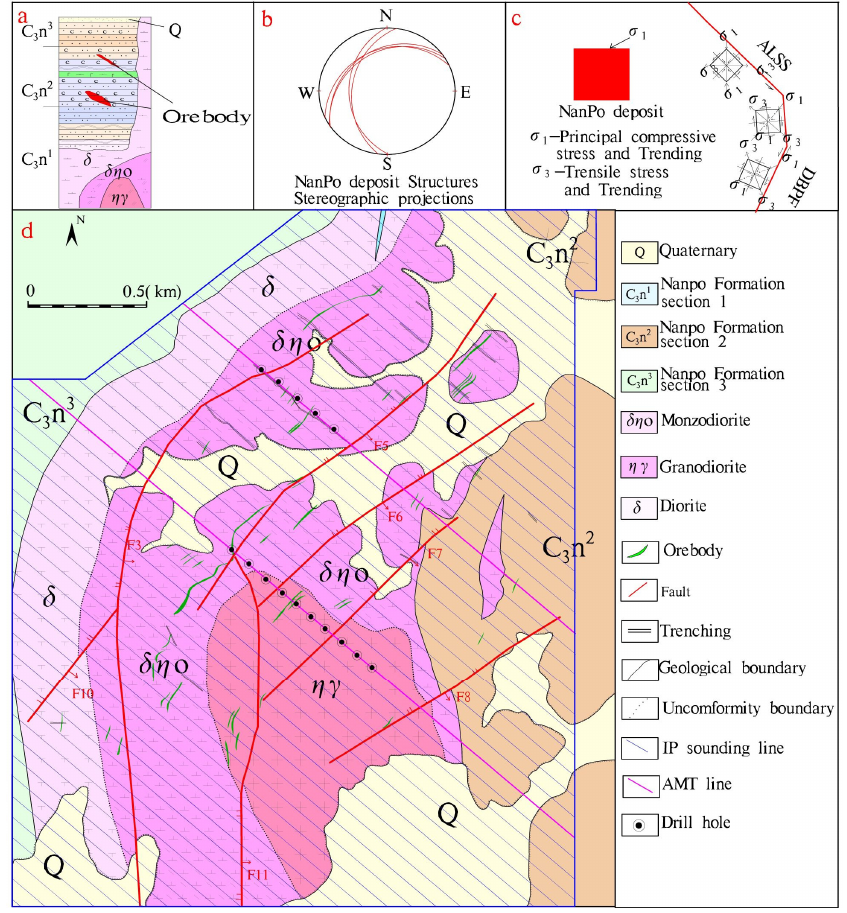
Figure 2. ( a ) Depositional sequence; ( b ) structural orthographic projection of the Nanpo deposit (S hammer sphere, equal area); ( c ) regional tectonic stress analysis sketch; ( d ) geological map of the Nanpo deposit district. ALSS: Ailaoshan suture, DBPF: Dian Bien Phu fault.